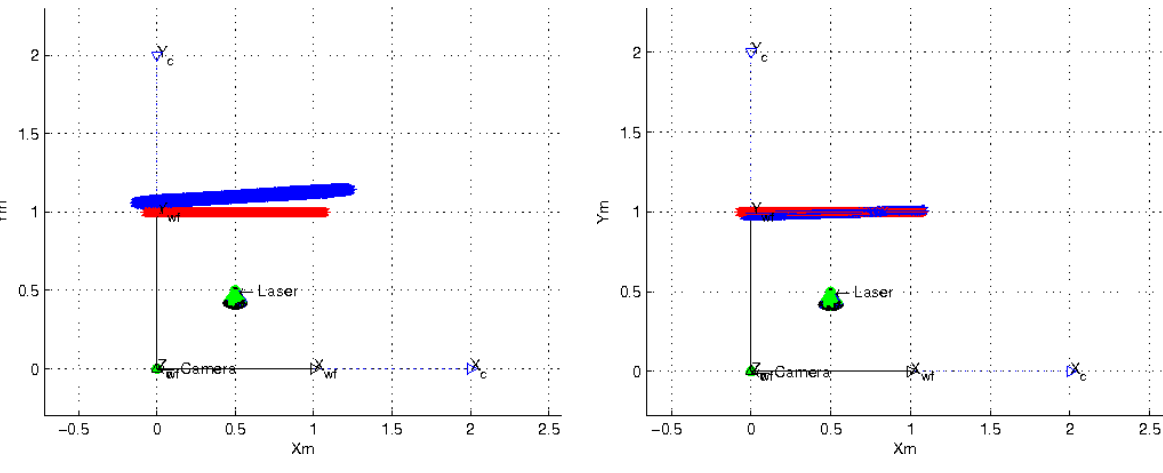
Figure 9. Estimation of a plane located 1 m from the camera. Real plane in red and estimated plane in blue. ( a ) Plane computed using One-endpoint method; ( b ) Plane computed using Two-endpoint